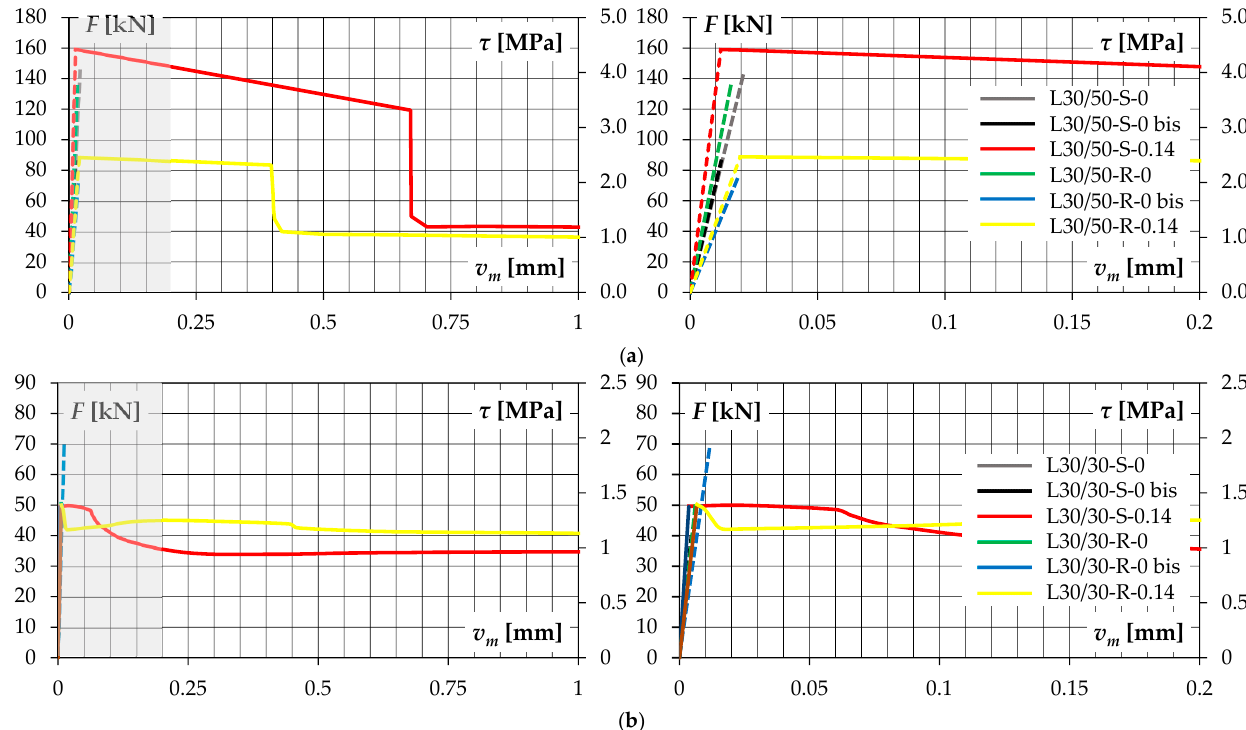
Figure 11. Applied force—slip relationships for test specimens of: ( a ) L30/50 series, ( b ) L30/30 series. The average slip v m at interface cracking was very small and did not exceed about 0.02 mm. A certain variability of the recorded values was observed in the initial range, which resulted from the technical possibilities and the accuracy of the applied measurement technique. For this reason, the course of slip as a function of load up to the crack formation was shown with a dashed line to indicate the presumed nature of this relation- ship. Two or even three times higher values were recorded for the L30/50 series ele- ments—the slip v m was about 0.012–0.021 mm, while in case of the L30/30 specimens with LWAC overlay of lower strength they amounted only about 0.004–0.012 mm—see Table 8. However, attention should be paid to the different destructive forces in both series.